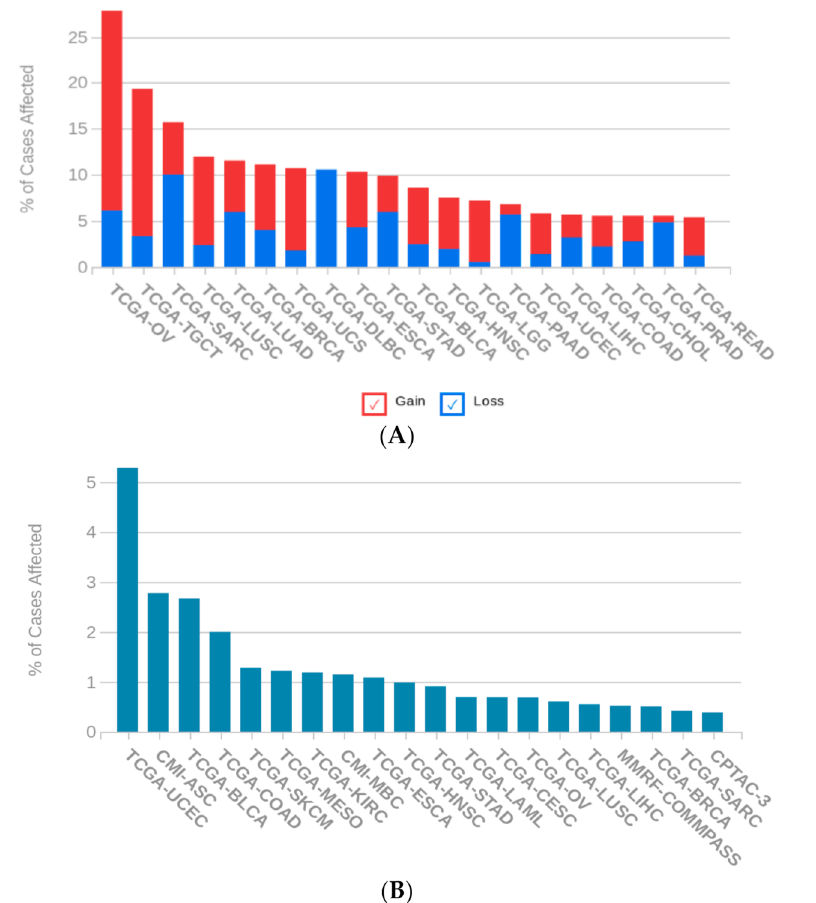
Figure A1. CNV and mutation distribution of CD27 in different cancer types. ( A ) CNV distribution. ( B ) Mutation distribution.